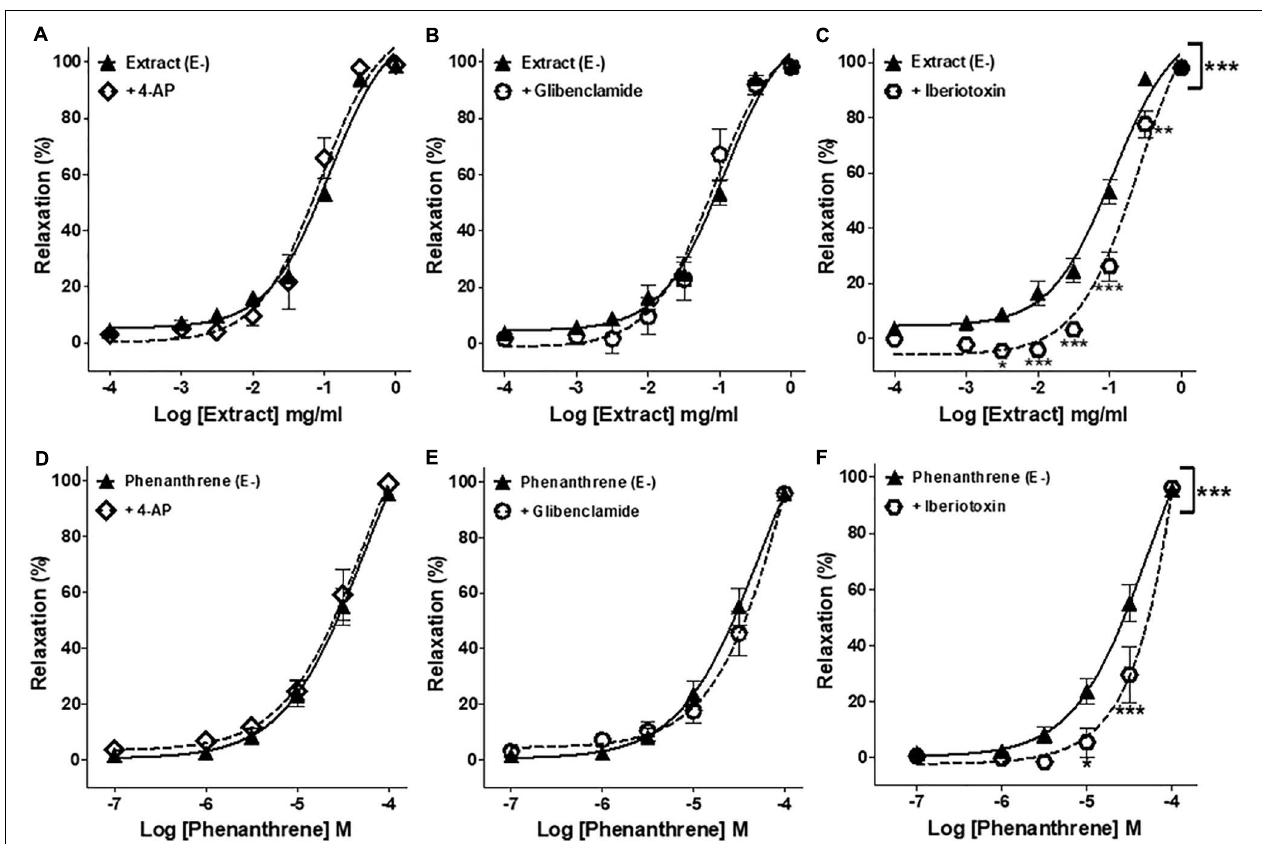
FIGURE 3 | Effects of different pharmacological inhibitors on EM extract- or phenanthrene-induced relaxation. Relaxant effect of EM extract or phenanthrene on endothelium-denuded mesenteric rings (E–) were measured in the absence [extract (E–) or phenanthrene (E–)] or presence of 10 − 3 M 4-AP (A,D) , 10 − 5 M glibenclamide (B,E) or 10 − 7 M iberiotoxin (C,F) . Relaxations are expressed as % contractions induced by 10 − 5 M PE. Values are means ± SEM of n individual arteries. ∗ p < 0.05, ∗∗ p < 0.01, ∗∗∗ p < 0.001 vs. Extract (E–) or phenanthrene (E–) ( n = 9–18).